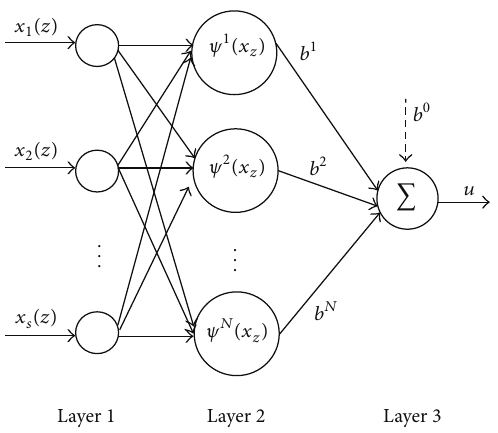
Figure 2: Three-layer network structure of a 3D